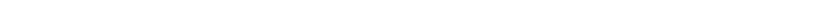
Algorithm 2 Dataset